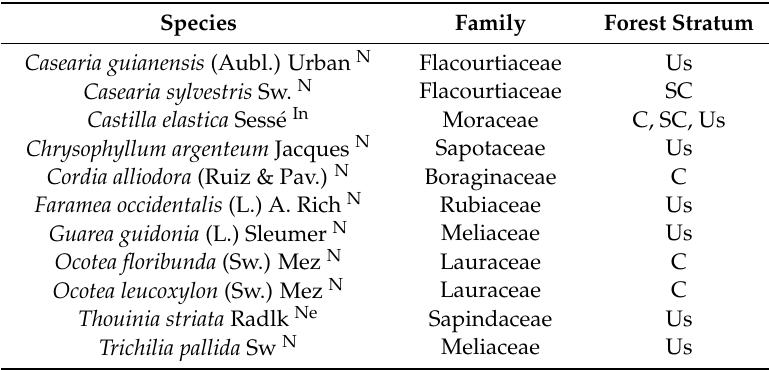
Table 1. List of species analyzed, their botanical families, and the forest stratum at novel Castilla forests. Taxonomic classification follows